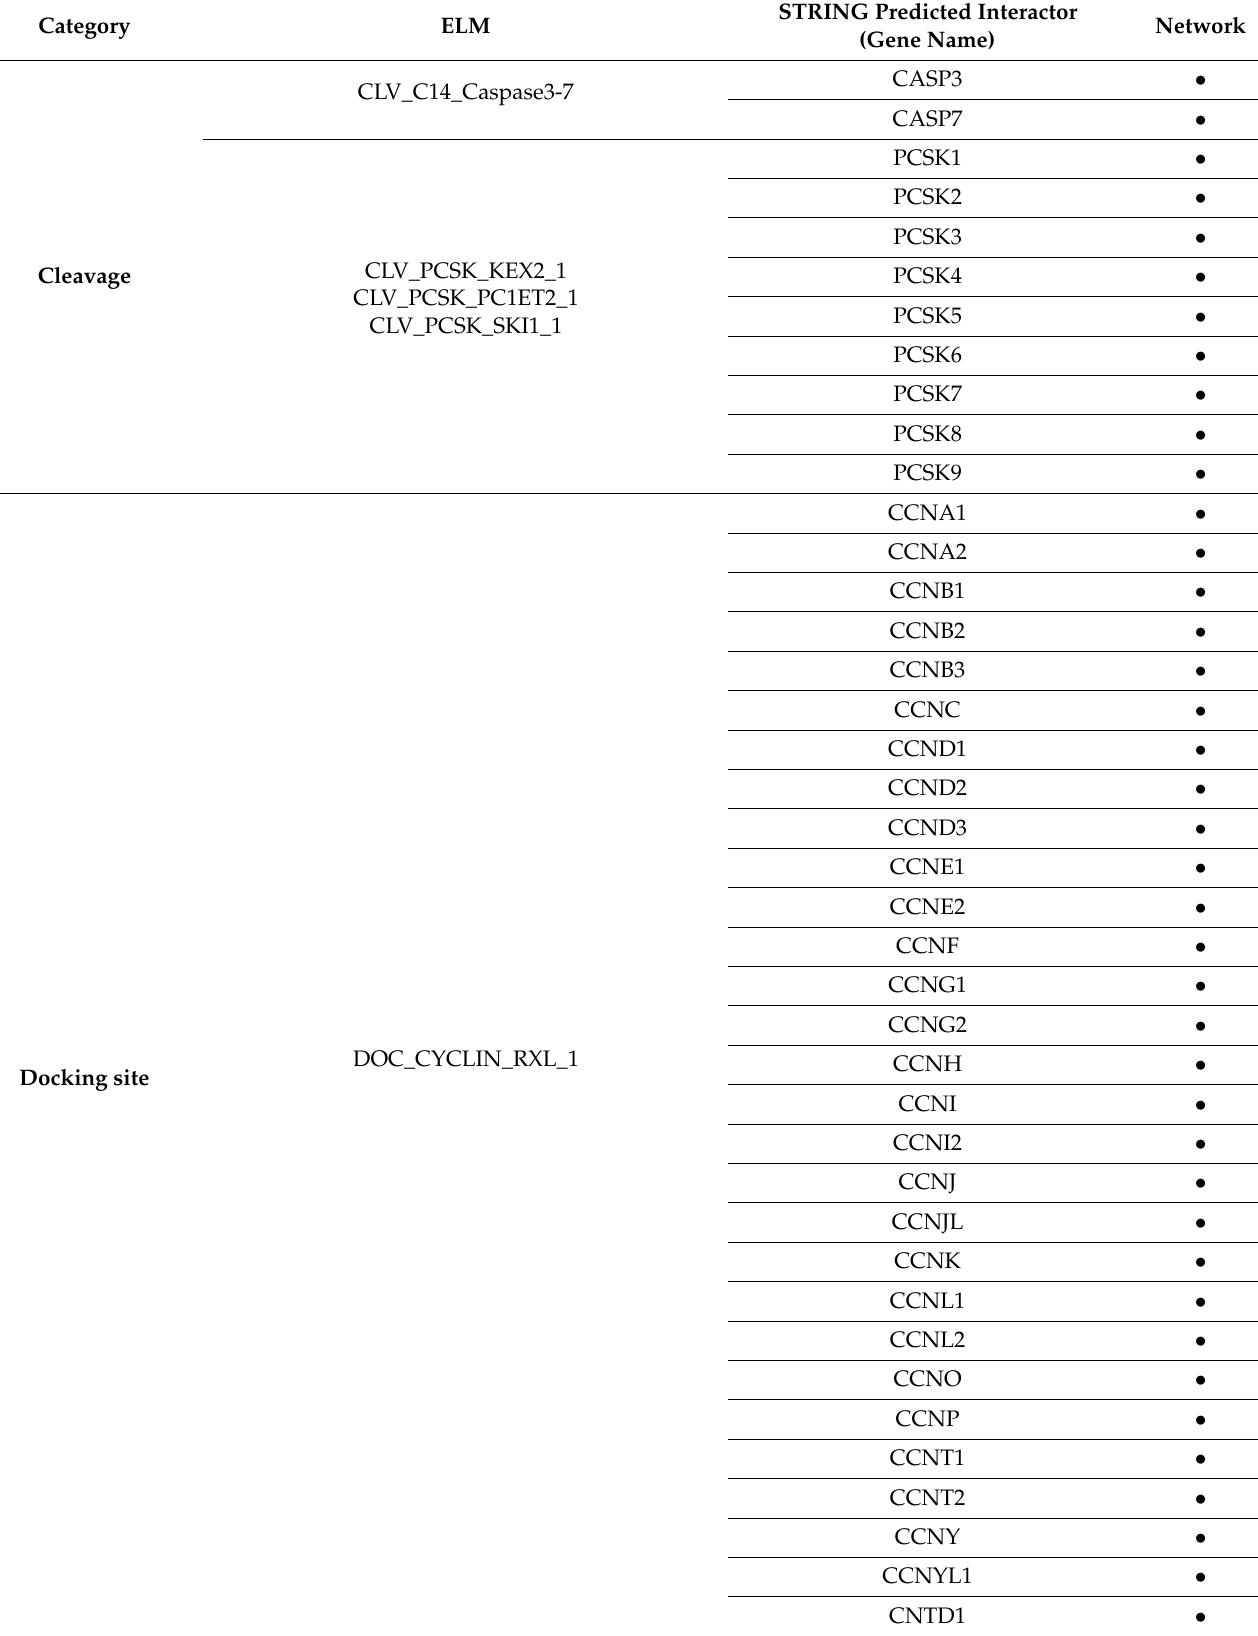
Table A5. List of query proteins for STRING analysis based on ELM interaction motifs in ERVK